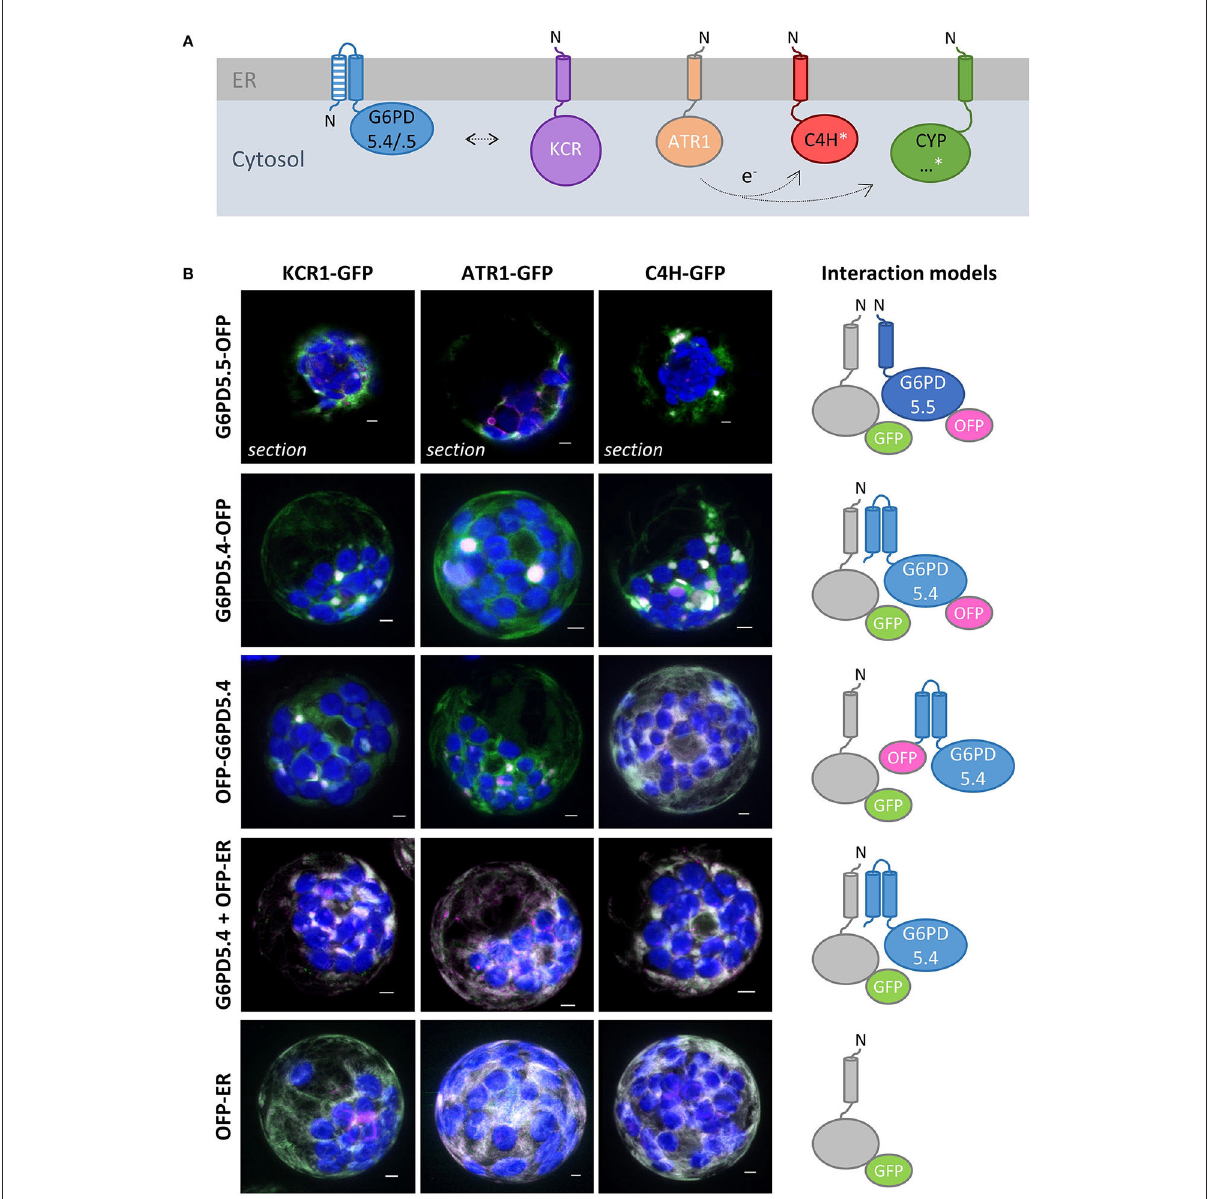
FIGURE9 NADPH-dependent enzymes co-localize with membrane-bound G6PD5 in ER subdomains. (A) Scheme of membrane-bound enzymes that consume NADPH at the cytosolic face of the ER, either directly (white) or indirectly (white asterisk): KCR1, ketoacyl-CoA reductase (part of the fatty acid elongase complex); ATR1, NADPH-dependent cytochrome P450 oxidoreductase (reduces cytochrome P450 enzymes, CYP) like C4H/CYP73A5 (cinnamate 4-hydroxylase, involved in the biosynthesis of phenylpropanes) and found upon GFP-G6PD5.4 pull-down (for ratiometric ro GFP analyses, confirming that the catalytic domains face the cytosol, refer to Supplementary Figure S8). (B) Co-expression of the GFP fusion proteins with either G6PD5.5-OFP, G6PD5.4-OFP, or N-terminally tagged OFP-G6PD5.4, and with the soluble luminal ER marker (OFP-ER) with label-free G6PD5.4, compared to OFP-ER alone (bottom). If not stated otherwise, the images show maximal projections of about 30 optical sections as a merger of all channels, (for single channel images, refer to Supplementary Figure S9). GFP in green, OFP in magenta, and chlorophyll auto-fluorescence in blue. White signals indicate co-localization of GFP and OFP (or very close signals < 200nm). Scale bars, 3 µ